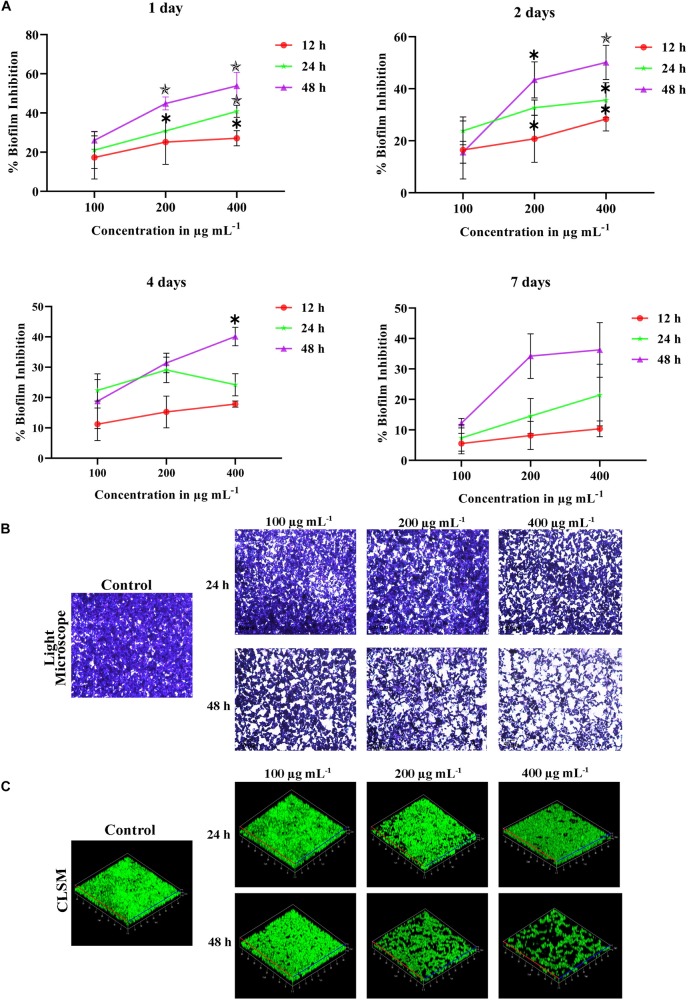
(A) Time killing of 1, 2, 4 and 7 days matured biofilm formed by C. tropicalis by PA at different time points (12, 24, and 48 h) and concentrations (100, 200, and 400 μg mL−1. The values are expressed as means and error bars indicate standard deviation of triplicates (n = 6). Control and PA-treated for 24 h and 48 h C. tropicalis biofilm (7 days matured) formed on 10 × 10 mm glass surfaces, as observed under (B) optical (Magnification – 400 ×, Scale bar – 50 μm) and (C) Confocal Microscope. ✽p < 0.05, ✯p < 0.01, and p < 0.001, significantly different when compared with control.